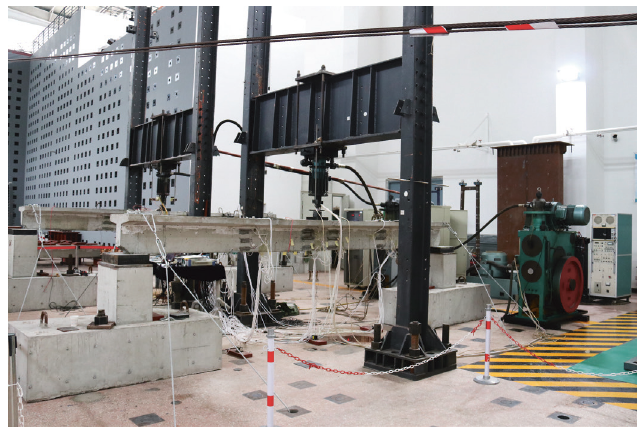
Figure 3. Test layout in the